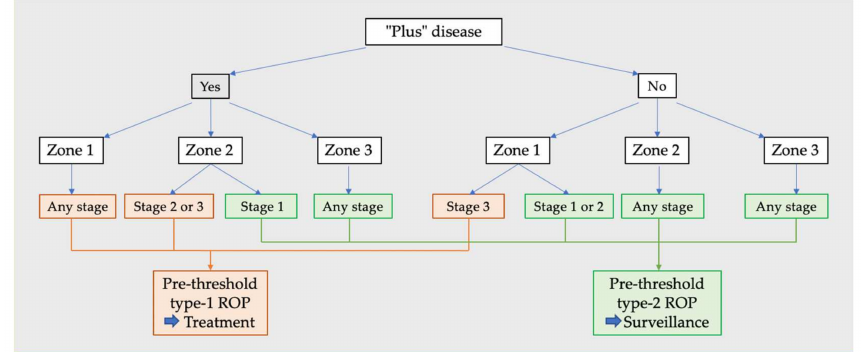
Figure 1. Pre-threshold type 1 and type 2 ROP (Retinopathy of